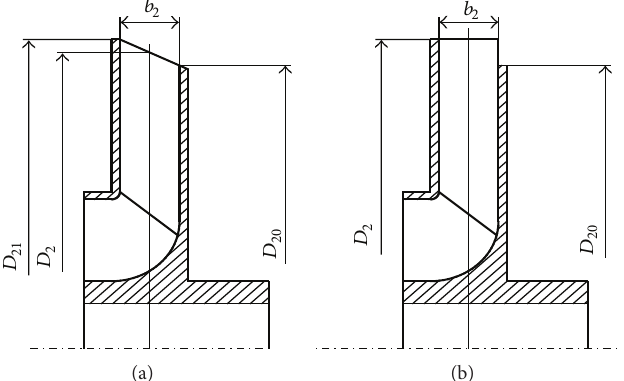
Figure 5: Two cutting proposals: (a) cutting blade outer edge and hub plate and (b) keeping blade and cutting hub